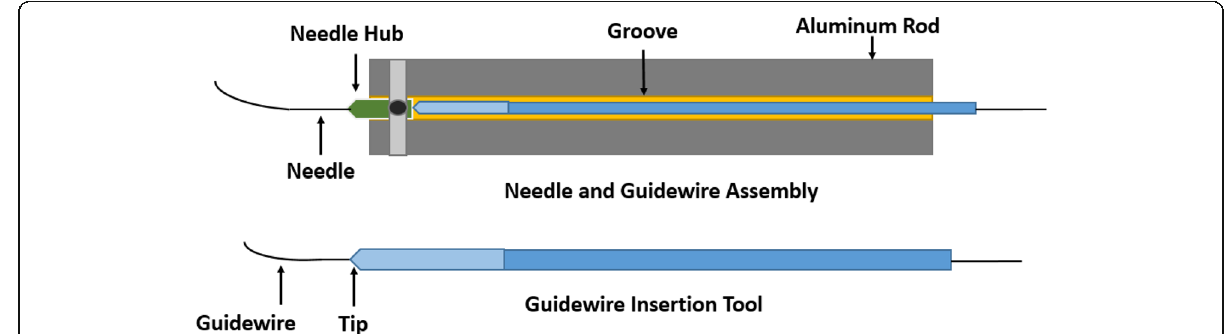
Fig. 2 Needle and guidewire holder. The guidewire was inserted inside the guidewire insertion tool. The guidewire insertion tool was placed in the groove of the needle holding assembly. The tip of the guidewire insertion tool was inserted inside the hub of the